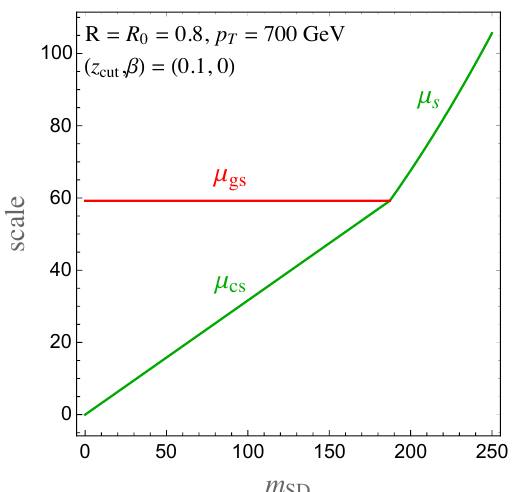
Figure 3 . Canonical global soft scale (cid:22) gs and collinear soft scale (cid:22) cs , which merge into the soft scale (cid:22) s at the point m J = m 0 . For m J > m 0 the grooming is no longer